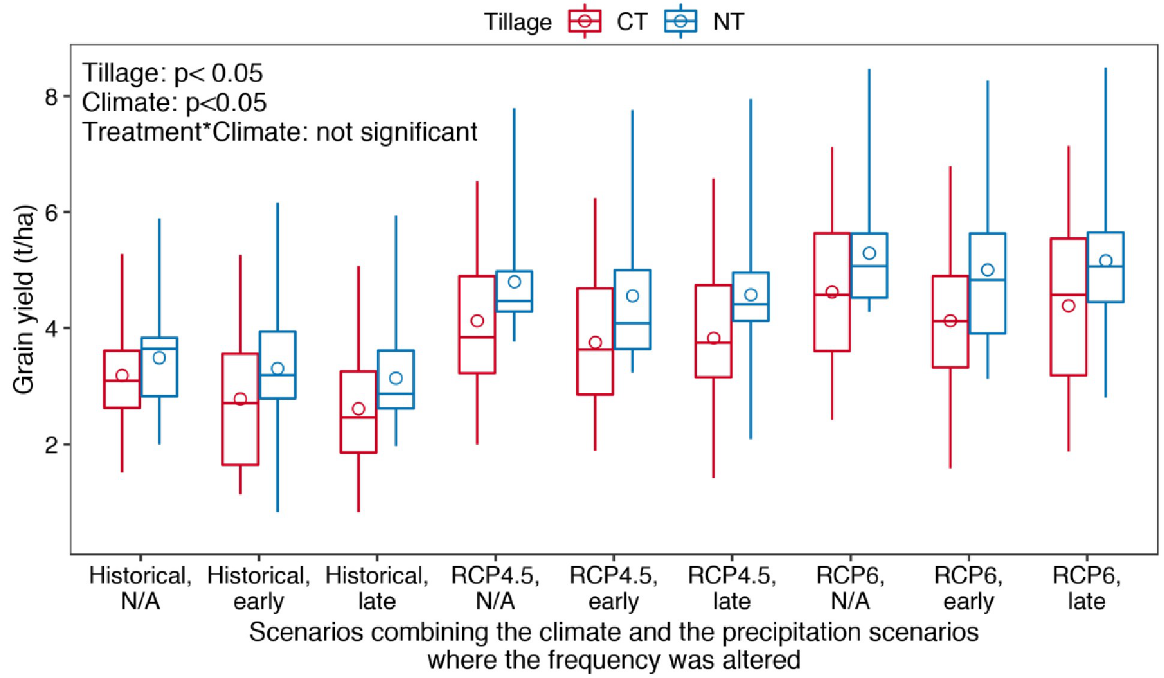
Fig 6. Distribution of the simulated wheat grain yield under conventional (CT) and no-till (NT) treatments in the simulated 24 years under the nine climate treatments that combines three greenhouse gas concentration paths scenarios (historical, RCP4.5 and RCP6) and three precipitation frequency scenarios (no changes in precipitation frequency (N/A), and drought and heavy rainfall imposed for early or late growth stage) (p values are from the two-way ANOVA analysis; the top and the bottom of the box represent the first and the third quartile values, respectively; the line within the box presents the median value; the top and the bottom ends of the whiskers represent the maximum and the minimum values, respectively; the circle represents the mean value).